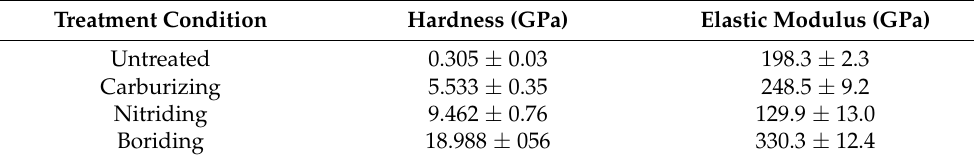
Table 7. The hardness and the elastic modulus values for the different hardening treatments.